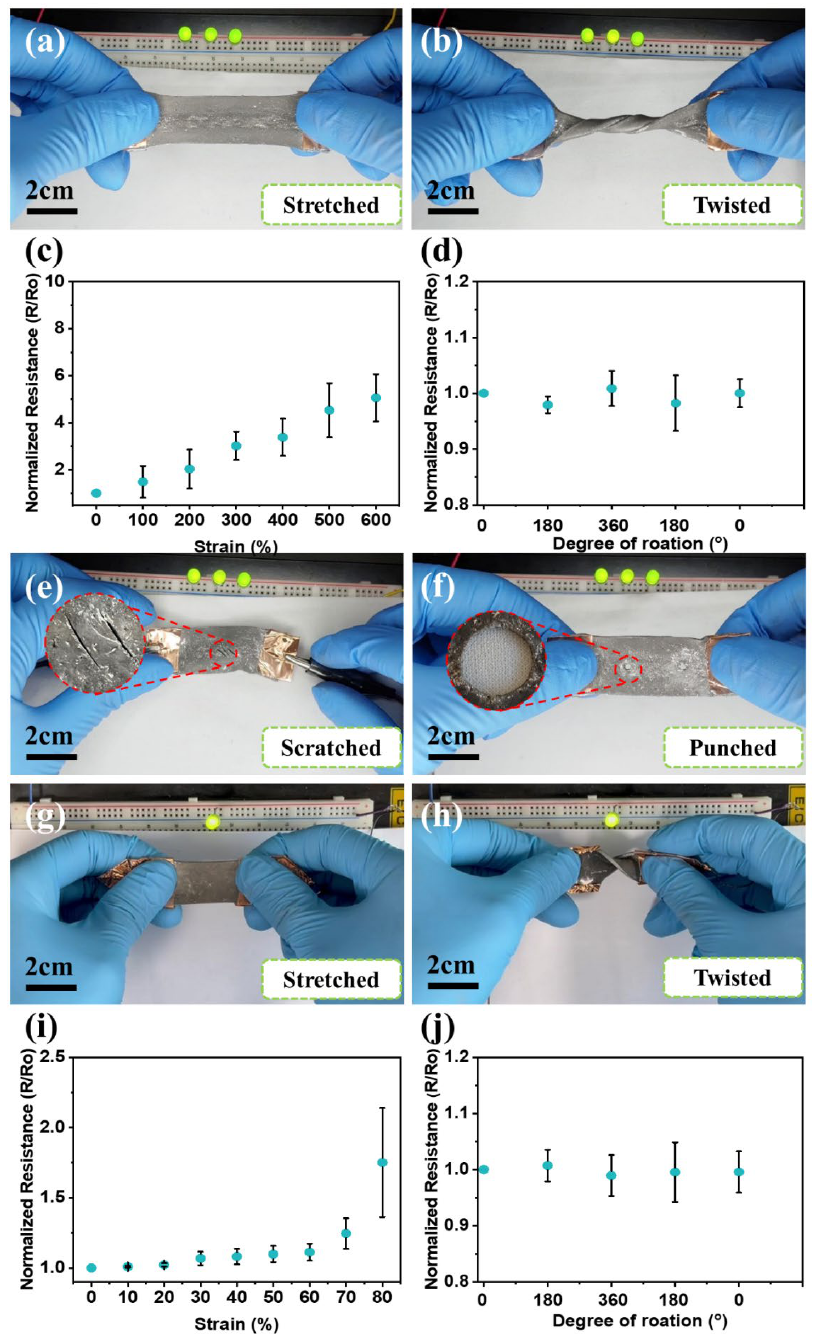
Figure 4. Photographs of ( a – f ) the ExSil 100-LM films and ( g – j ) the Sylgard 184-LM films showing electrical conductivity while strained. The ExSil 100-LM films were subjected to ( a ) stretching, ( b ) twisting and folding, ( e ) scratching, and ( f ) punching. ( c , d ) The effective normalized resistance of the ExSil 100-LM films upon ( c ) stretching and ( d ) twisting. The Sylgard 184-LM films were also subjected to ( g ) stretching and ( h ) twisting. ( i , j ) The effective normalized resistance of the Sylgard 184-LM films upon ( i ) stretching and ( j ) twisting.